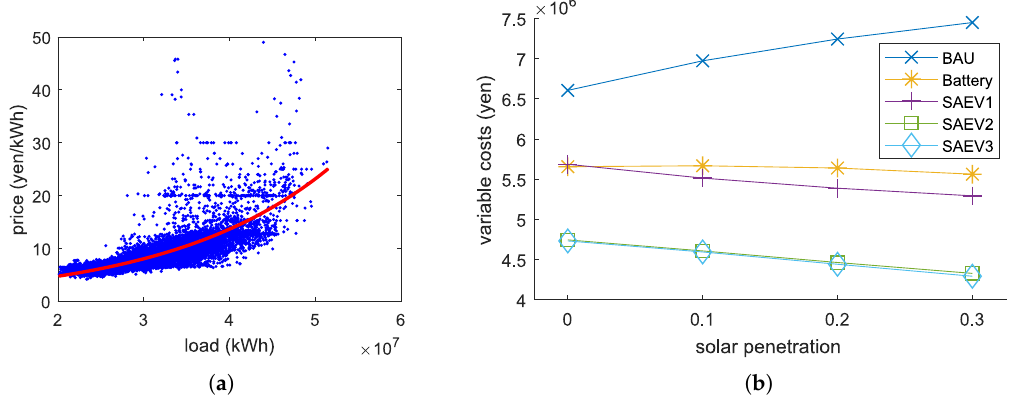
Figure 7. Effect of increasing solar penetration in the grid ( a ) Exponential fit of the relation between prices and dispatchable generation on the Japan Electric Power Exchange (JEPX) in 2017; and ( b ) Variable costs of the system for increasing solar